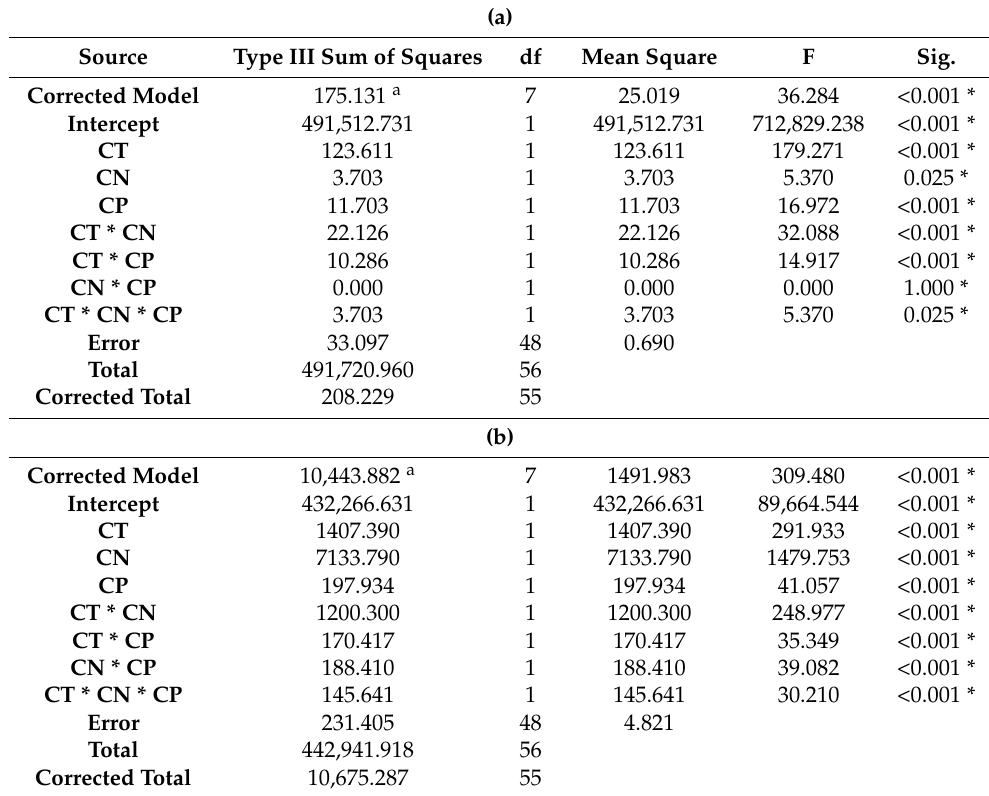
Table 4. ( a ) Tests of Between-Subjects Effects (dependent variable: COD removal); ( b ) tests of Between-Subjects Effects (dependent variable: NH 3 -N removal); and ( c ) tests of Between-Subjects Effects (where dependent variable: PO 43 − -P